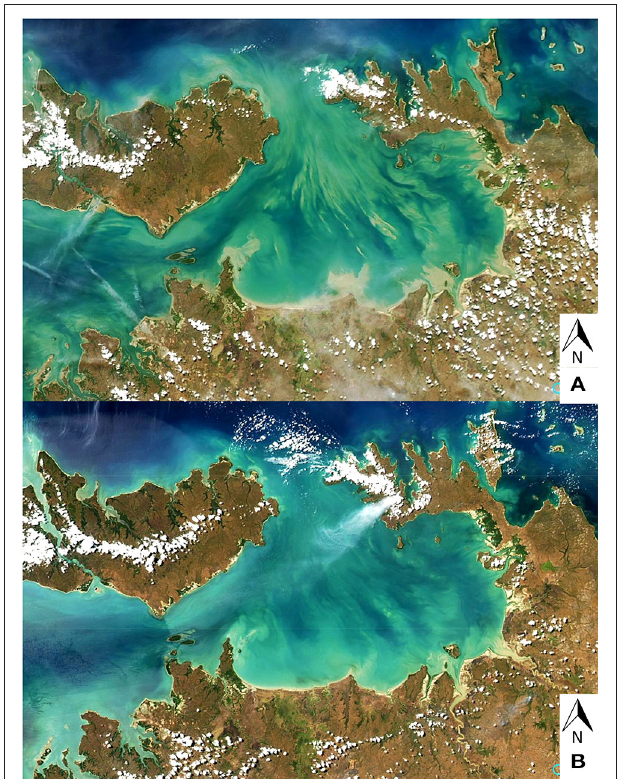
FIGURE 15 | Large spatial variability of suspended sediment depending on the tidal energy: MODIS-Aqua 250-m resolution images during the dry season 2013 field campaign. (A) 12 September 2013 (spring tide) and (B) 14 September 2013 (neap